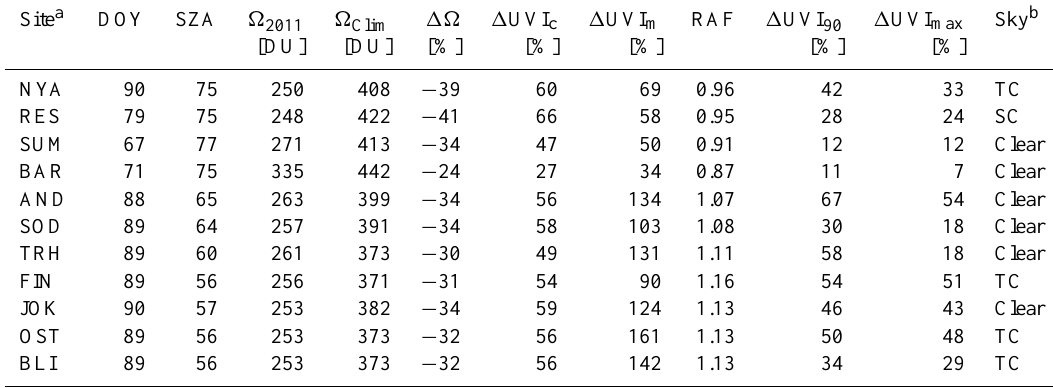
Table 3. Comparison of observed and computed UVI